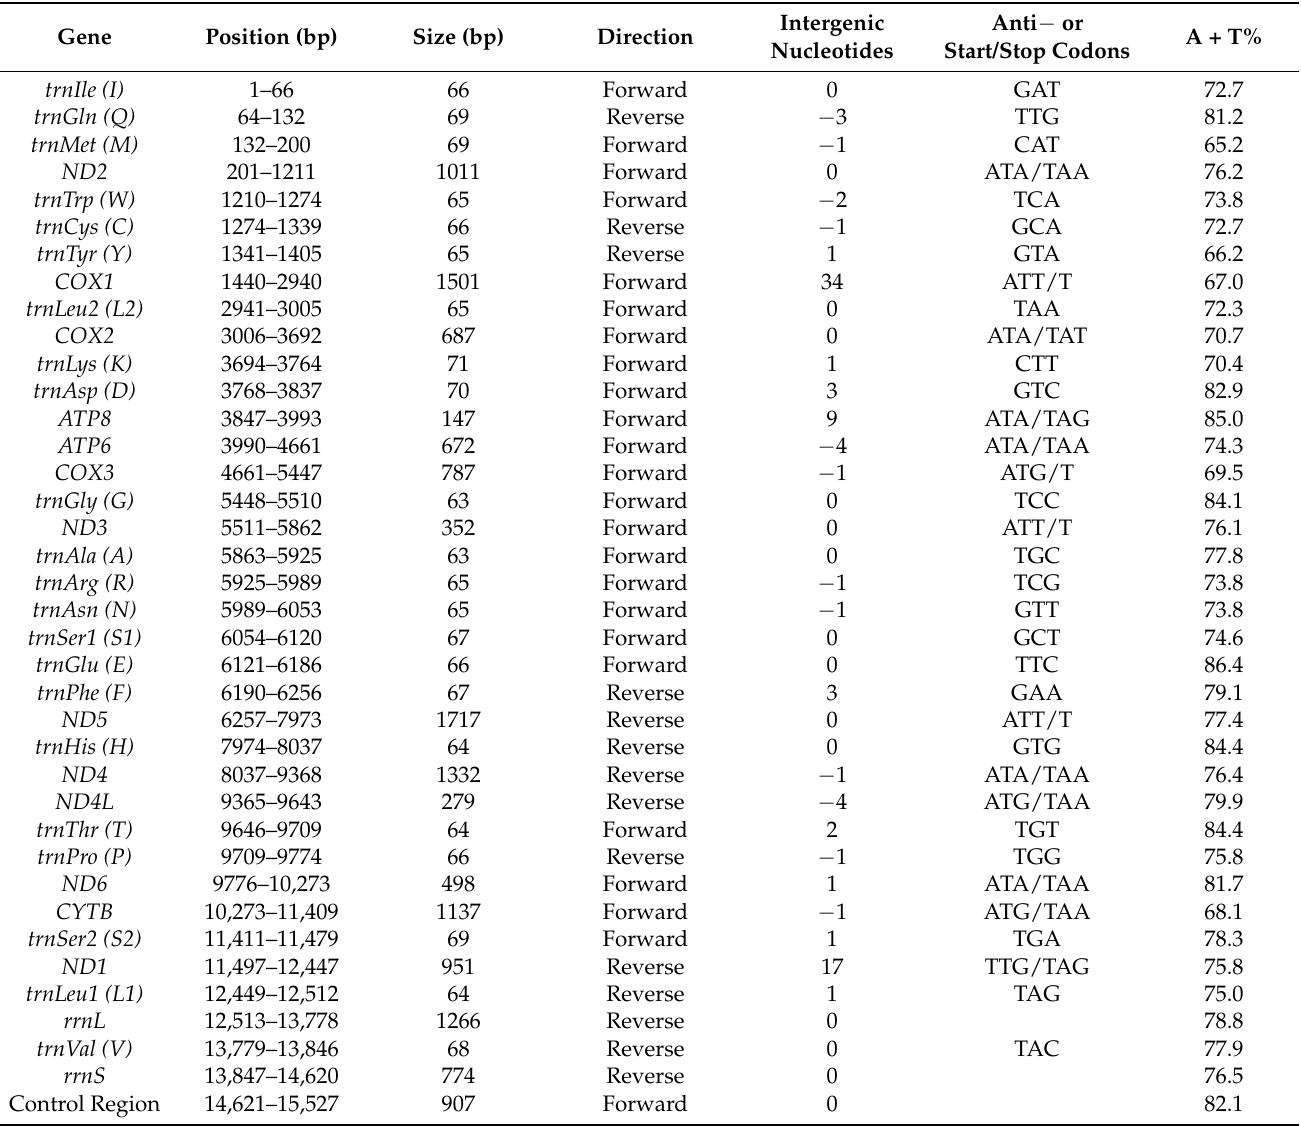
Table 3. Mitochondrial genome organization of D. pseudonotabilis